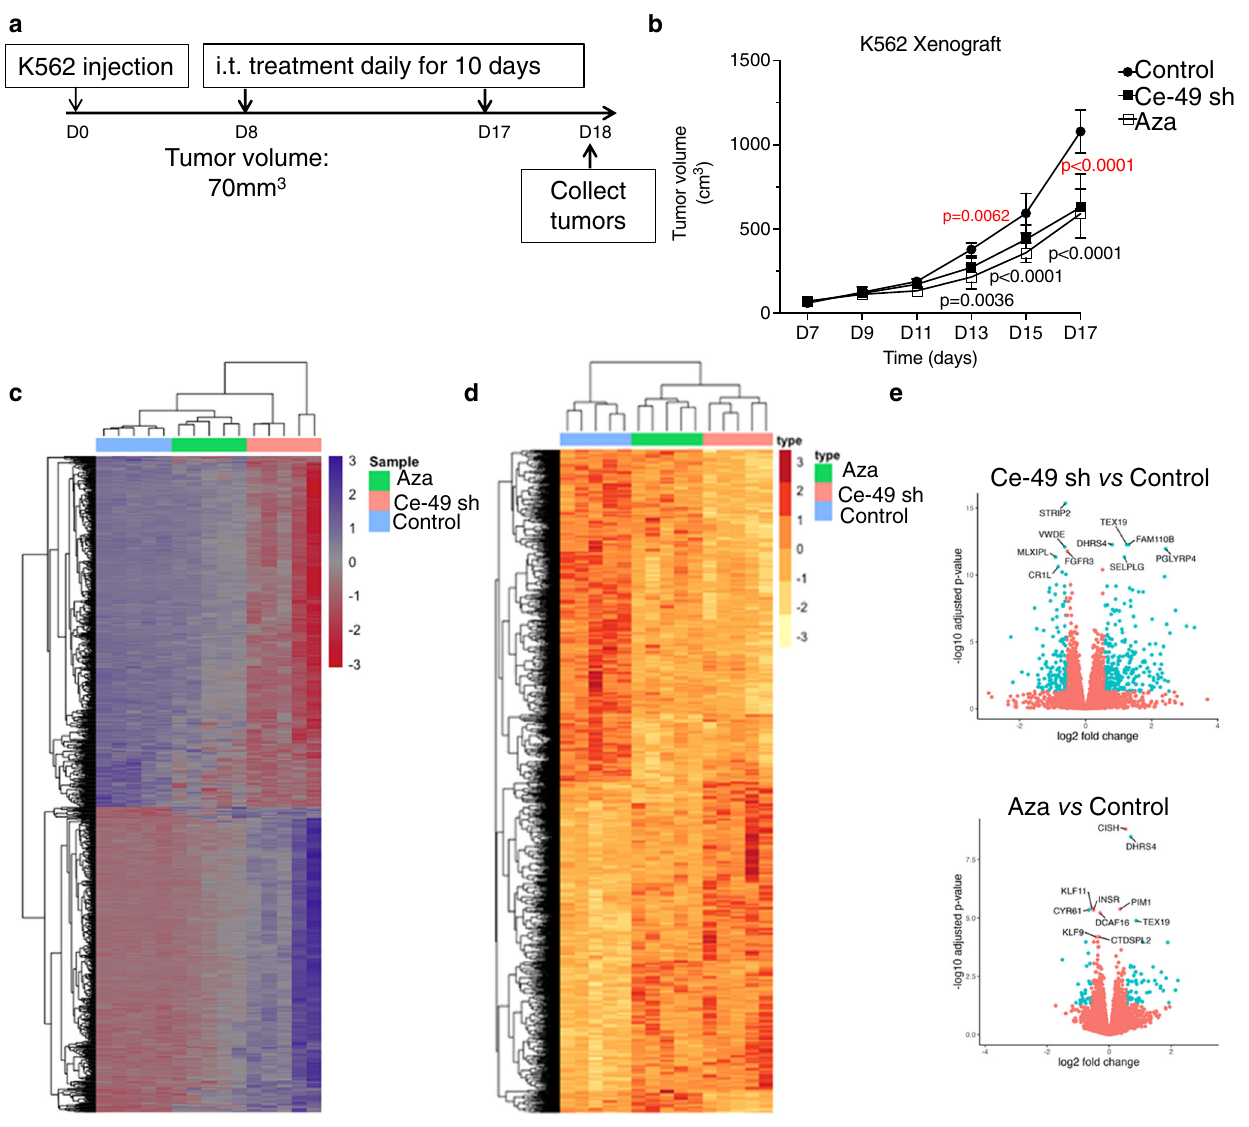
Fig. 9 | In vivo validation of Ce-49 sh. a Scheme of the in vivo experiment. ( b – e ) NSG mice bearing K562 tumours were daily-injected intratumorally with PBS (control) or Ce-49 LNPs or 5-Aza. Following 10 days of treatments, mice were then sacri fi ced. b Plot of tumour volumes measured by caliper. Error bars depict mean±SD.StatisticsofCe-49sh versus PBS(red)or5-Aza versus PBS(black)bytwo- way ANOVA are reported (n=5 biological samples). Source data are provided as a